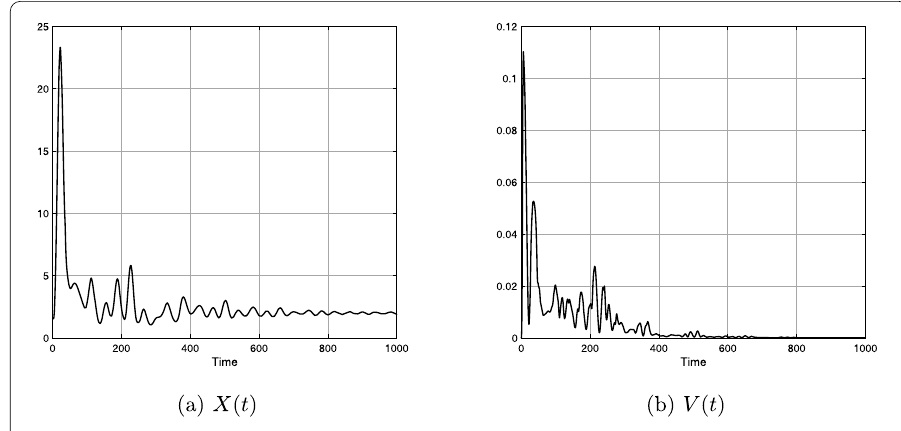
Figure 14 Dispersion and disagreement of Case IV for t ∈ [0,1000]